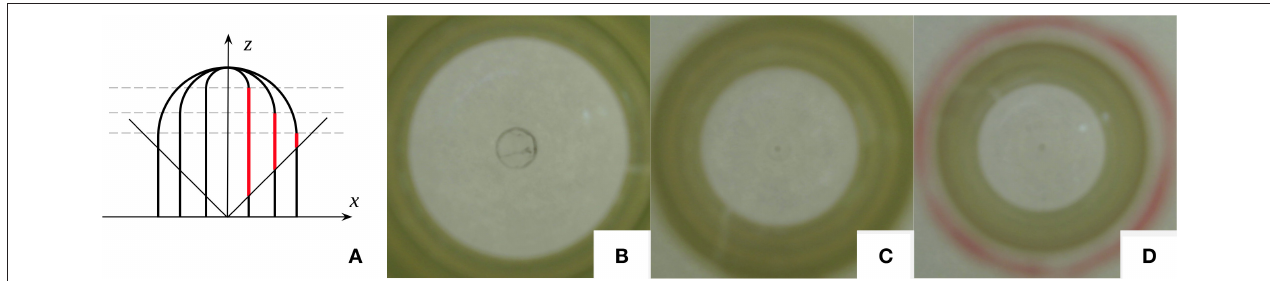
FIGURE 5 | (A) Three sensor designs of different radiuses and their lateral observable areas (highlighted in red). It should be noted that for tubes with the same length (given the same camera viewing angle), the larger the radius is, the shorter is the lateral observable area. (B–D) Images captured using three test tubes of different diameters: 21, 15, and 13mm, respectively. The three have the same depth d of 3cm. A yellow and green electrical tape is placed on the cylindrical region of the tube, tangent to the discontinuity line. The tape has a width of approximately 14.5mm, and each of its green stripes has a width comprised between 1 and 2mm. For the thinner tube, an additional red line is traced approximately 2mm from the tape. The same camera and wide lens are used to capture the images.